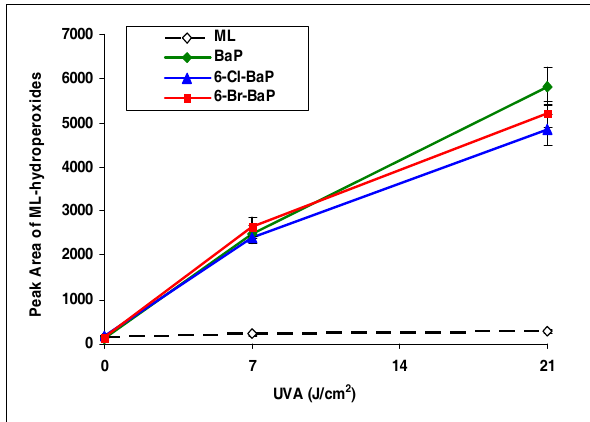
Figure 6: Peroxidation of methyl linoleate initiated by benzo[ a ]pyrene, 6-Cl-benzo[ a ]pyrene, 6-Br- benzo[ a ]pyrene, with, 0, 7, and 21 J/cm2 of UVA